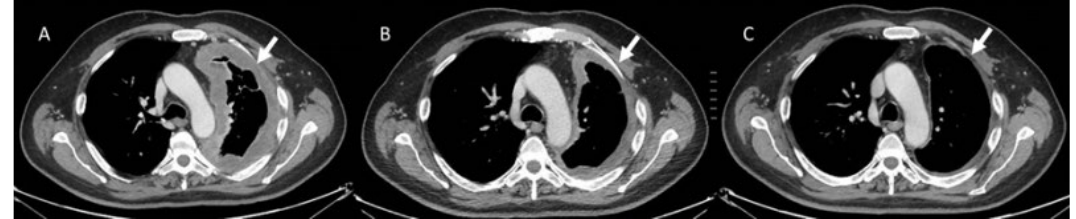
Figure 1. Complete response pattern in a mesothelioma patient treated with immunotherapy. CT scan assessment in pre-treatment phase ( A ) of lesion (arrow), at 3 months ( B ), and after 6 months ( C ).